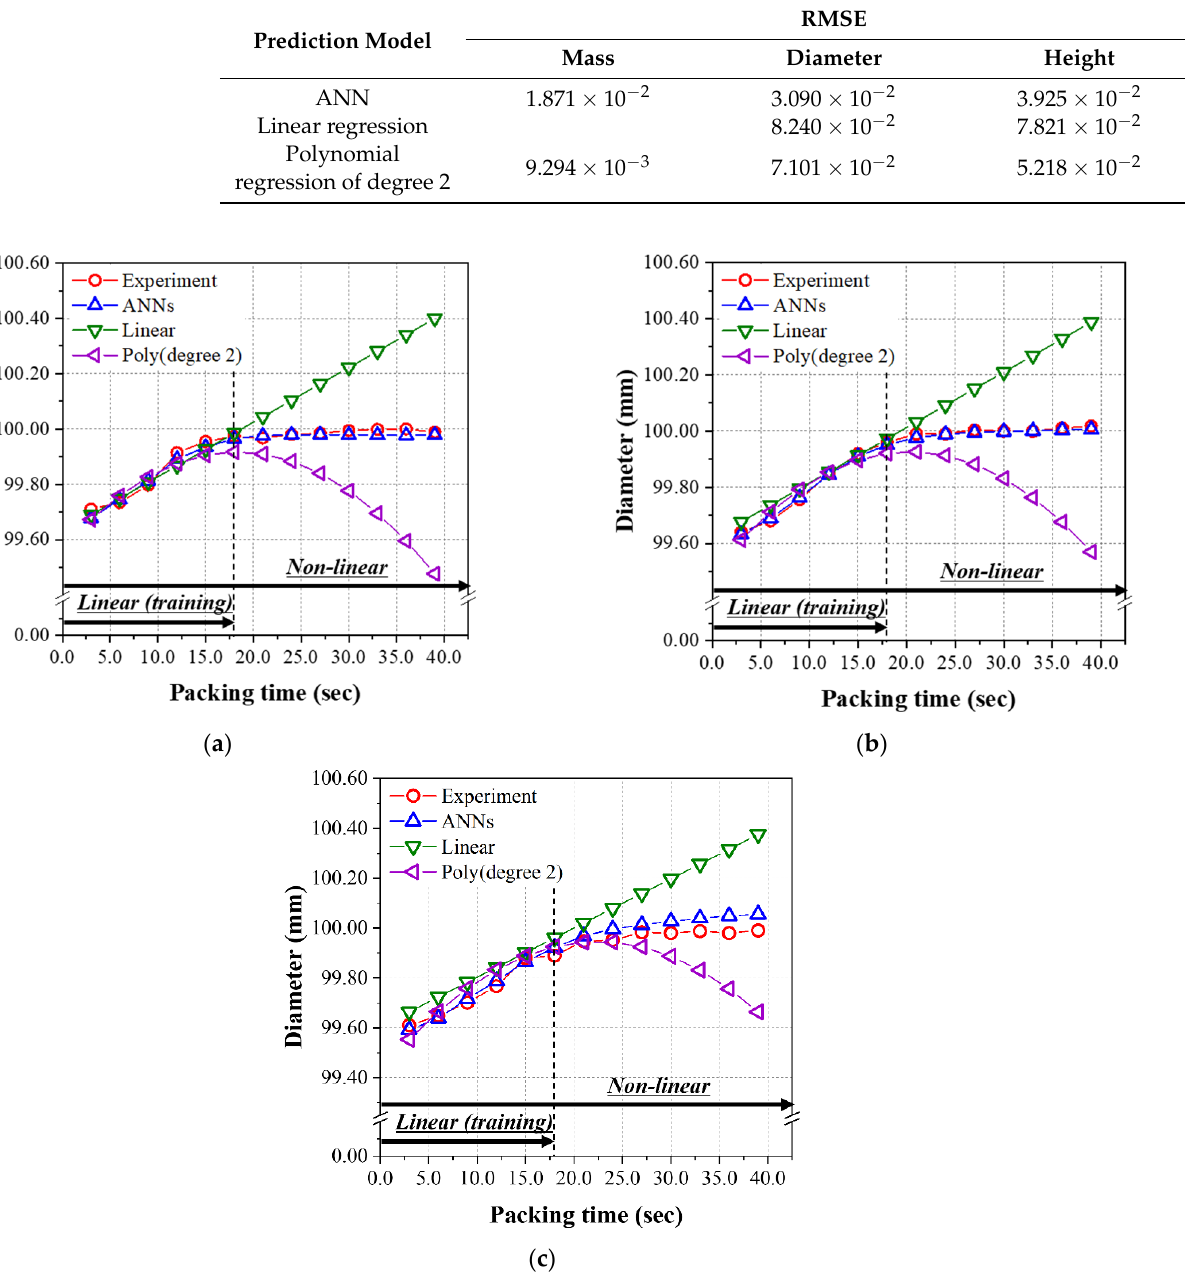
Figure 9. Predicted diameters of the nonlinear relation group from Table A2 using the models learned by the linear relation group (packing time was 3.0~18.0 s). Melt temperatures; ( a ) 200 °C, ( b ) 220 °C, and ( c ) 240 °C.